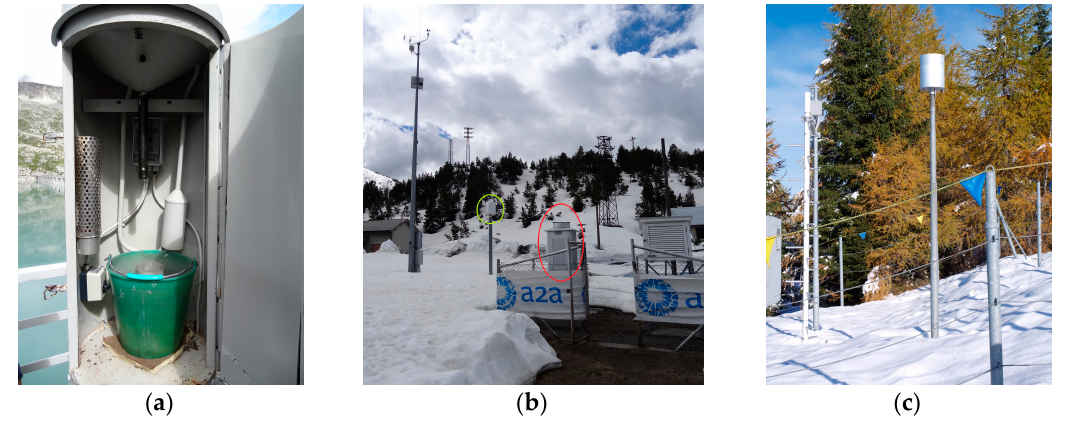
Figure 1. ( a ) Precipitation gauge at Pantano d’Avio (Brescia province, see also Figure 7b) monitoring site. The tank is inside a heated housing made by SIAP (Italian weather instruments manufacturer). On the left, the heating device, activated by a thermostat, here set to 4 °C. ( b ) Cancano monitoring site, where a CAE PMB2 electronic tipping-bucket heated gauge (yellow circle) is installed besidea heated mechanical SIAP one (red circle). ( c ) Electronic tipping-bucket heated gauge model CAE PMB2 at the Aprica Magnolta (SO) monitoring site.